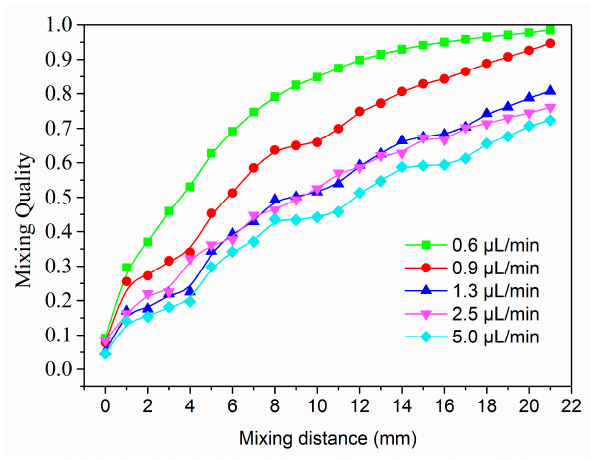
Figure 5. Comparison of the mixing quality along the mixing main channel under various flow rate.